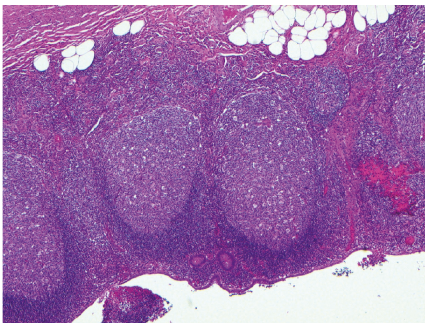
Figure 10: Omentum – focal granulation tissue formation.